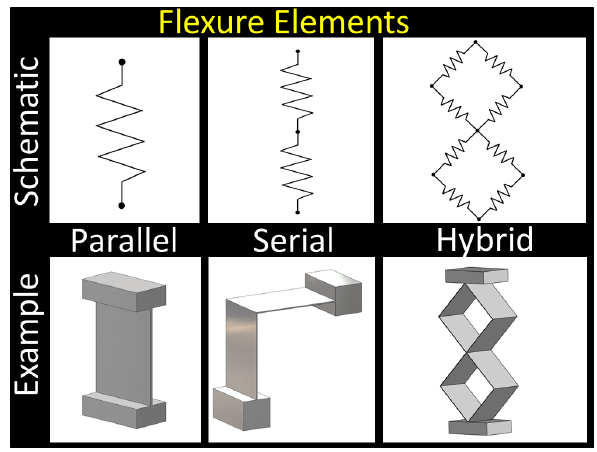
Figure 3. Three kinds of flexure elements—parallel, serial, and hybrid